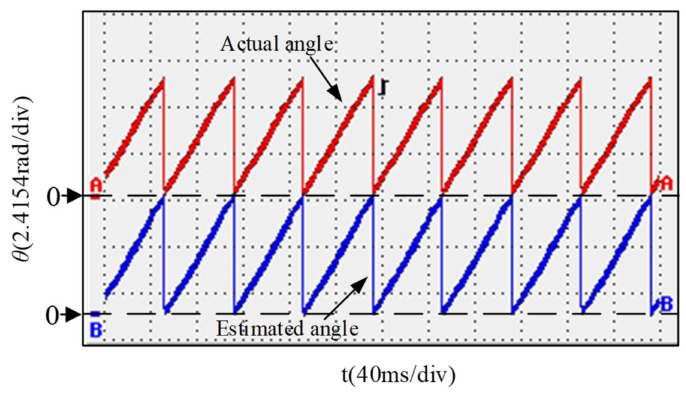
Figure 28. Rotor position angle waveforms at 500